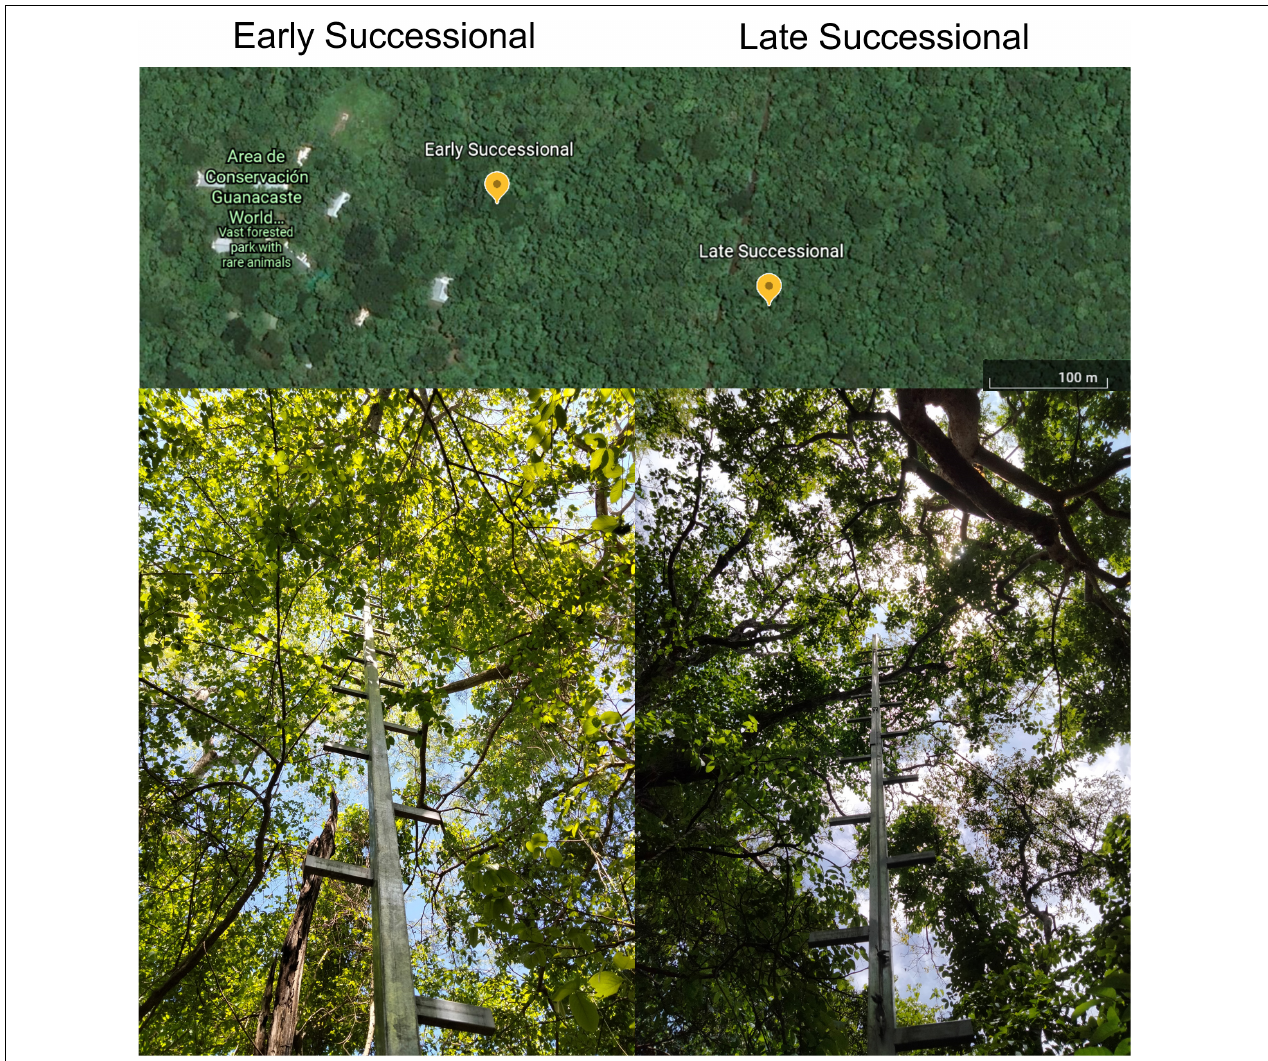
FIGURE 1 | Scaffold system used to fix five anemometers per tower at heights of 0.5, 3.5, 5.5, 7.5, and 10 m. The anemometers were moved between our early successional forest site and our late successional forest site at 2 week